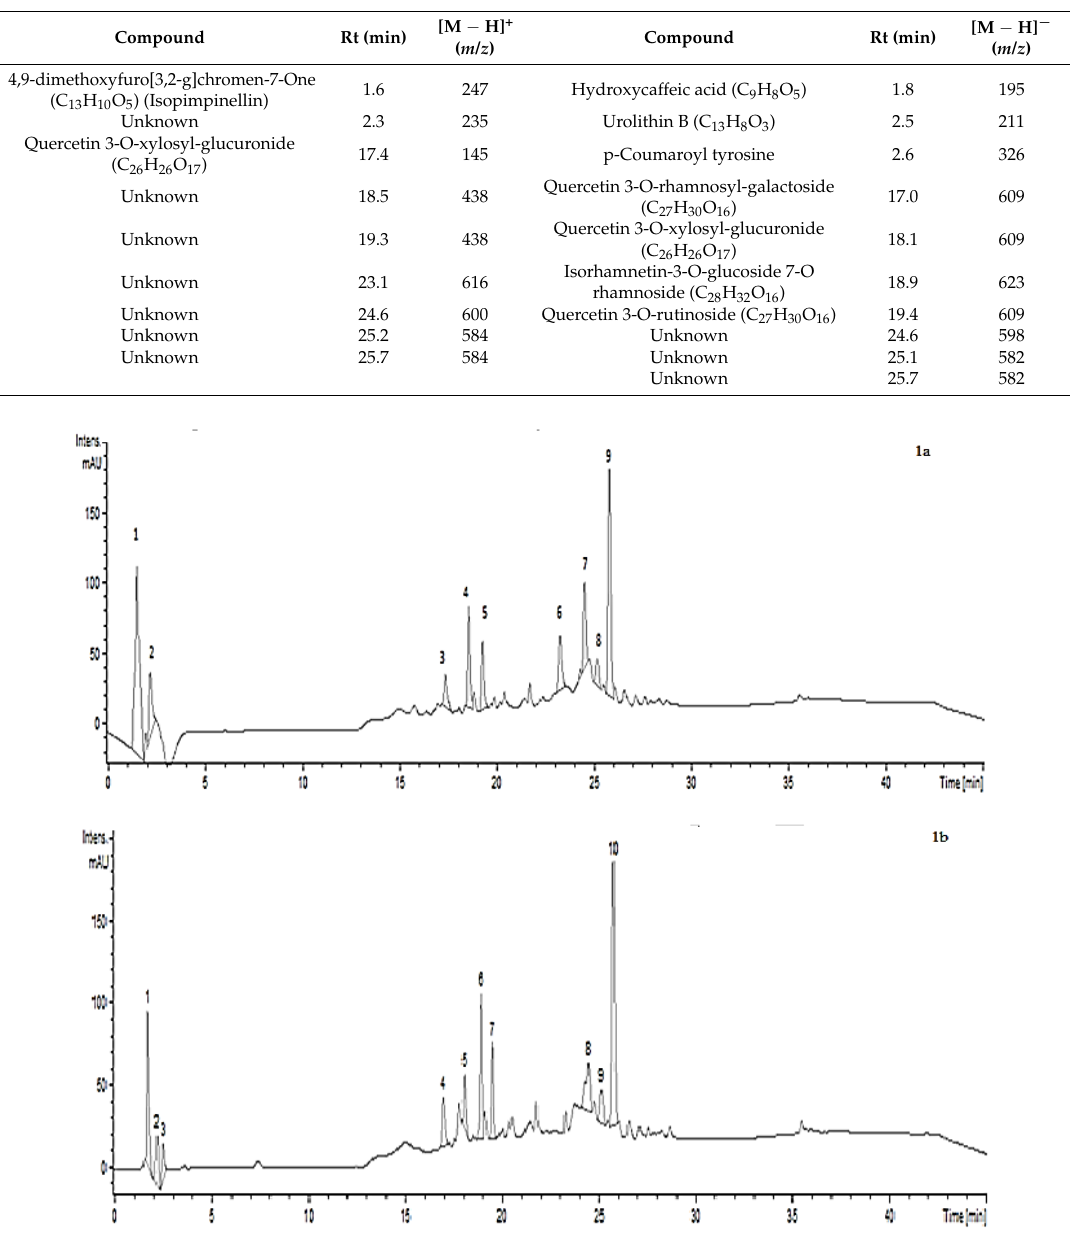
Figure 1. ( a ) A typical HPLC chromatogram of bee pollen ethanolic extract at positive mode.